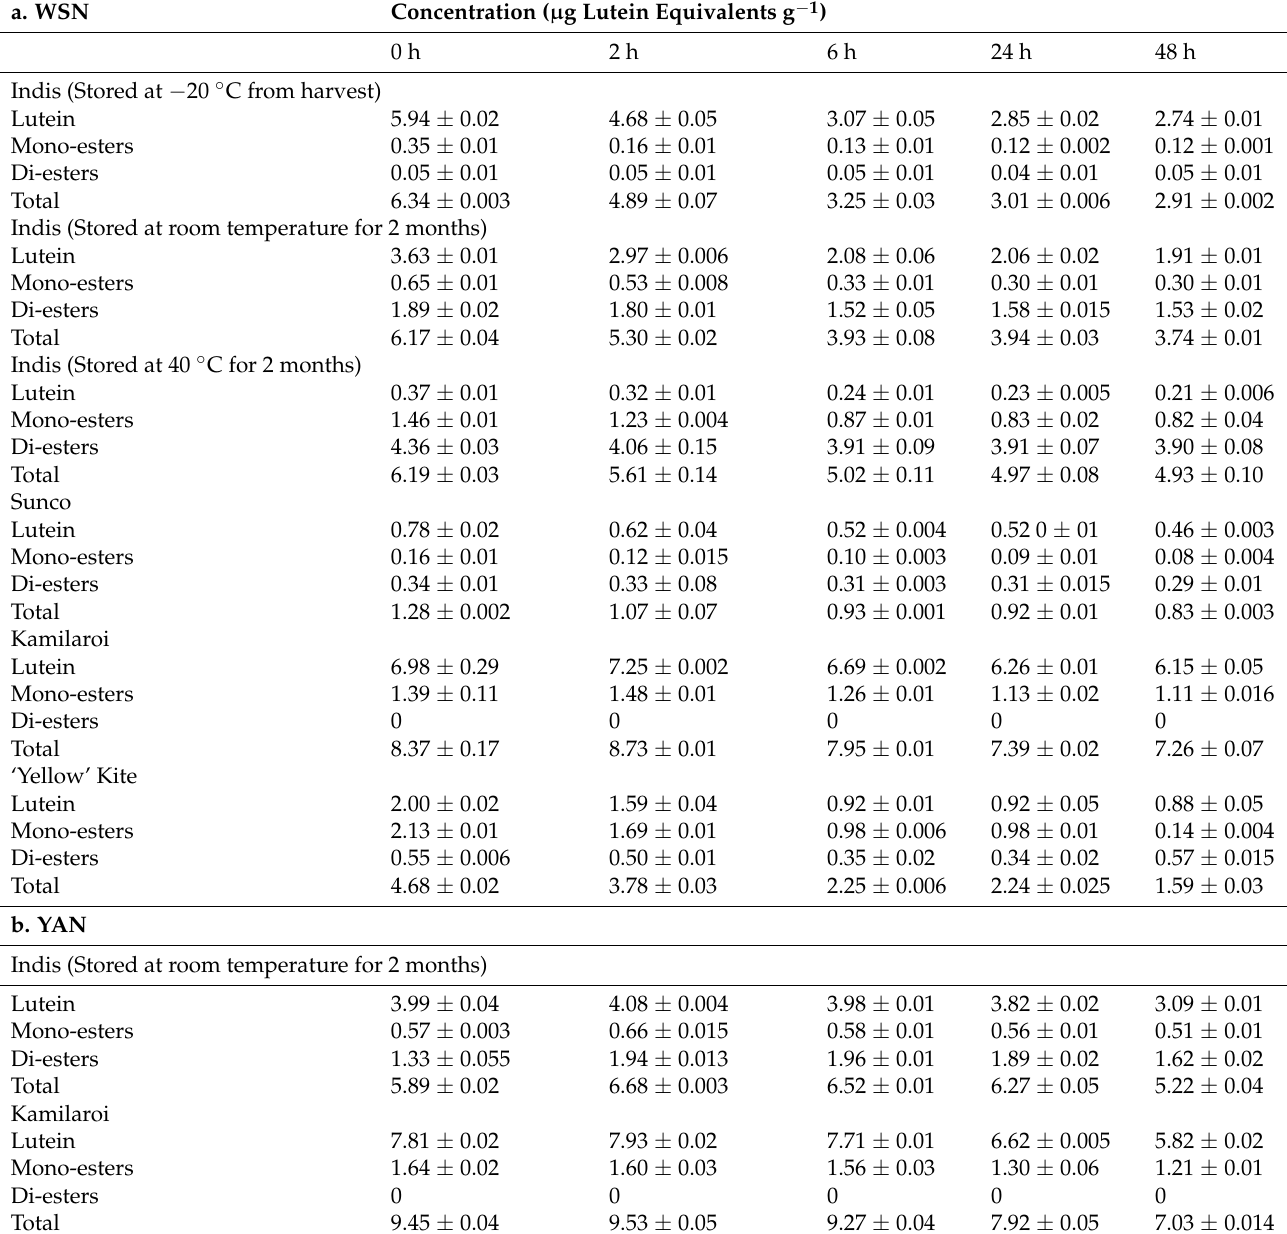
Table 1. Lutein and lutein ester concentrations in ( a ) white salted noodle (WSN) and ( b ) yellow alkaline noodle (YAN) sheets sampled 2, 6, 24 and 48 h after preparation. Figures after the ± symbol are standard